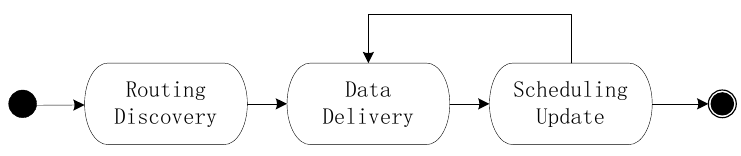
Figure 2. System running